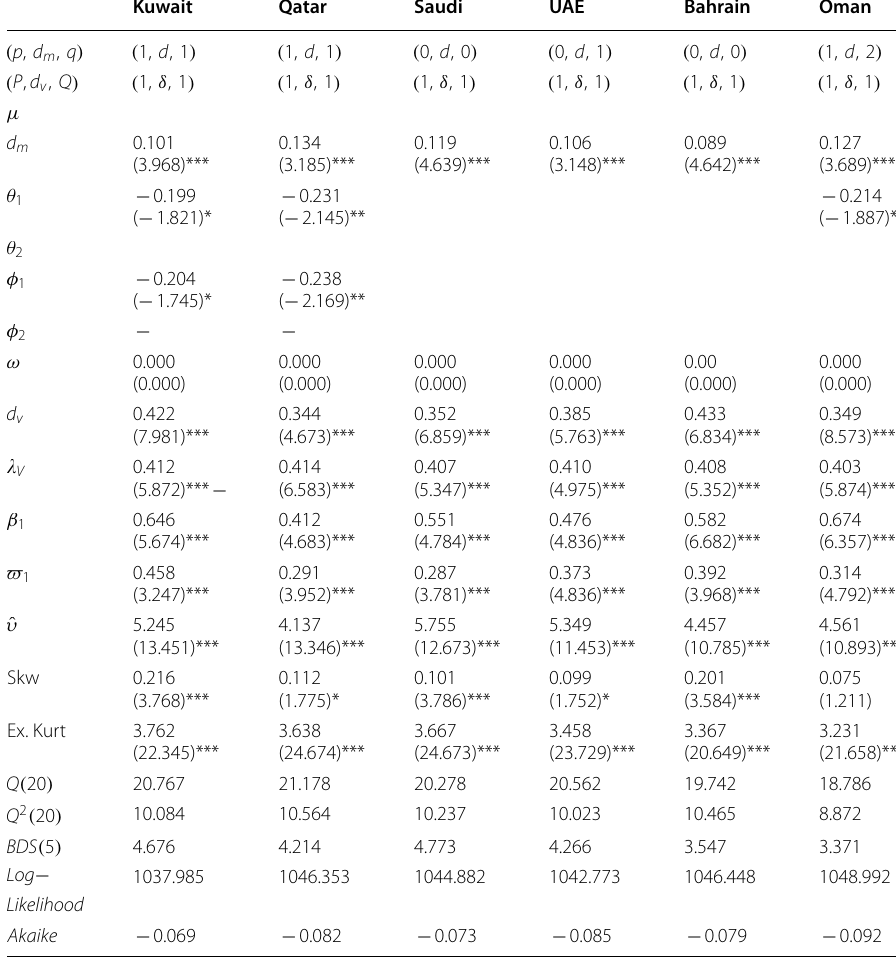
Table 3 Estimates of ARFIMA-G-GARCH model for each